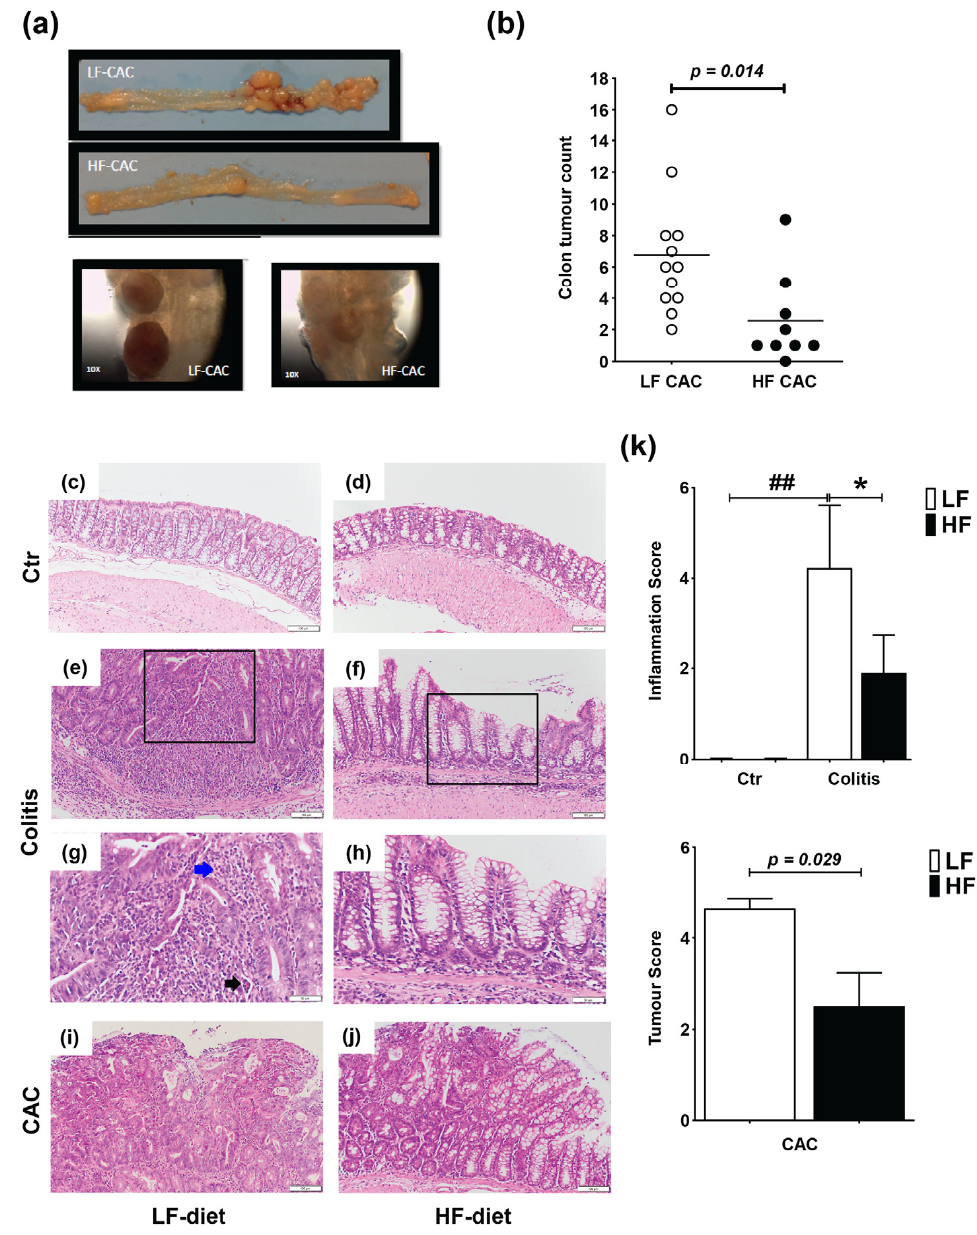
Figure 1. High-fat feeding reduces colitis and tumour development. ( a ) Representative images of the colon with tumours from mice with LF-CAC and HF-CAC at 4 × and close-up of tumours, 10 × . ( b ) Number of tumours per mouse fed LF and HF diet. Significance determined by two-tail unpaired Student’s t -test, * p < 0.014. Data are mean ± SEM. n = 8–12 mice per group, representative of two independent experiments. ( c – j ) Representative histology tissue sections stained with haematoxylin and eosin of distal colon from ( c ) LF- and ( d ) HF-fed control (Ctr) group; ( e , g ) LF- and ( f , h ) HF-fed mice with colitis, and ( i ) LF- and ( j ) HF-fed mice with CAC. Pictures in ( c–f ) are taken at 20 × zoom (Bar–100 µ m) and black boxes are inset in ( g , h ), at 40 × zoom (Bar–50 µ m). Blue arrow indicates neutrophils and black arrow indicates crypt abscess. Pictures in ( i , j ) are taken at 20 × zoom (Bar–100 µ m). ( k ) Histology inflammatory score in LF-/HF-Colitis compared to LF-/HF-Ctr groups, and tumour score in LF-CAC compared to HF-CAC mice. Significances were determined using ANOVA with post-hoc corrections (inflammatory score) and two-tail unpaired Student’s t -test (tumour score). * p < 0.05 HF-CAC vs. LF-CAC; ## p < 0.01 LF-Colitis vs. LF-Ctr. Data are mean ± SEM. n = 6–10 mice per group.